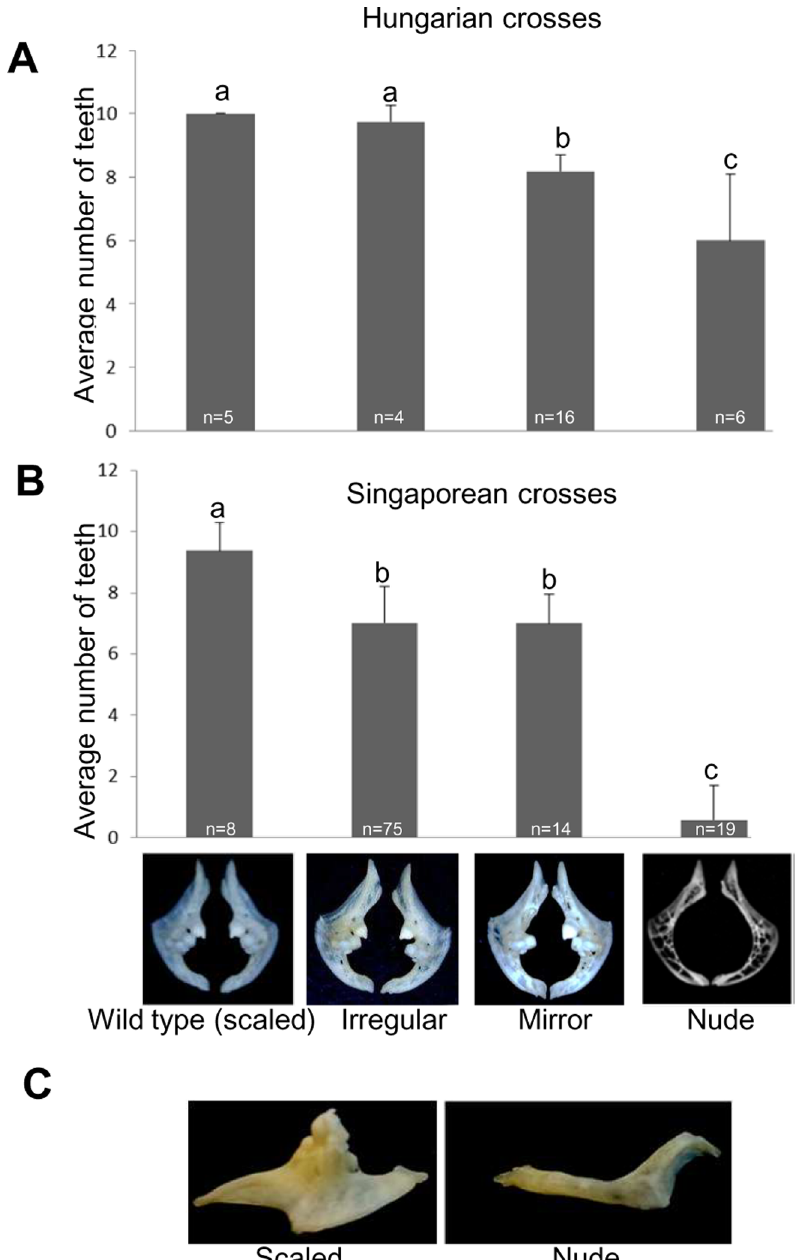
Figure 4. The number of pharyngeal teeth gradually decreases with the reduction of scale coverage from completely scaled to nudes. The average number of teeth is shown for the four scale-pattern phenotypes (scaled, irregular, mirror and nude) from individuals sampled in Hungary (A) and Singapore (B). Numbers in white at the bottom of the bars indicate the number of individuals analyzed from each scale-pattern category. Different letters on top of the bars indicate statistically significant differences (P-value: , 0.01, Student’s t-test). Images below panel B show a representative picture of pharyngeal teeth for each of the phenotypes analyzed in Singapore. Note the increased trabeculation and the holes in the pharyngeal arches isolated from the nude individual. Panel C: Side-view of a representative pharyngeal arch from a scaled and nude individual is shown.